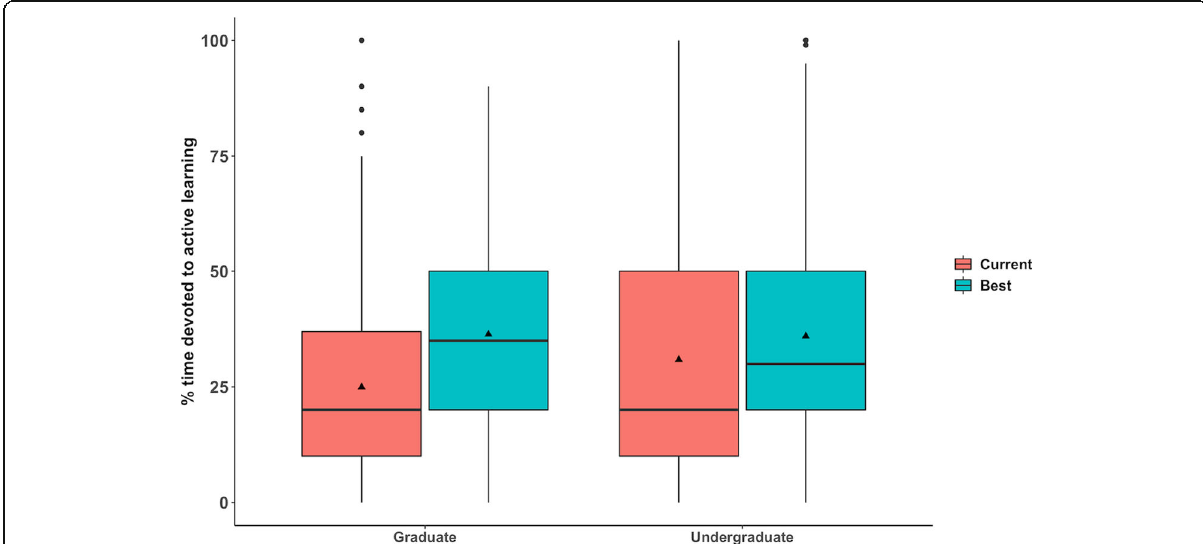
Fig. 2 Box and whisker plots of the percent of class time graduate and undergraduate students think is currently ( “ Current ” ) and should be ( “ Best ” ) devoted to active learning. Students were provided a definition of active learning (Miller & Metz, 2014) and via an open-ended response, asked to estimate the amount of class time typically devoted to active learning and how much time they think should be devoted to active learning. Triangles indicate mean values. *indicates p -values <